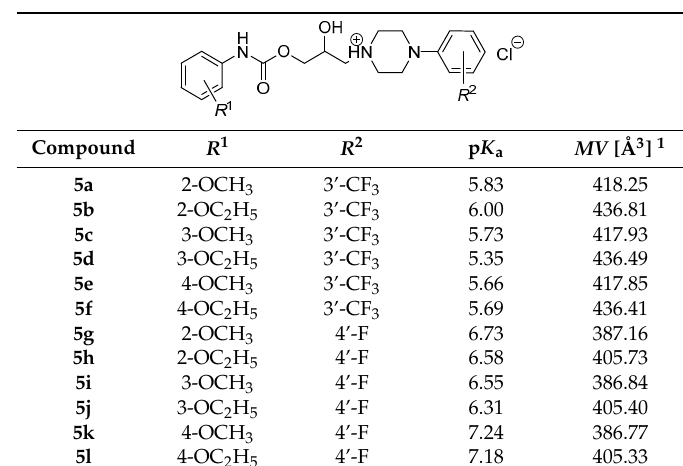
Table 1. Experimentally observed values of the dissociation constants (p K a ) of the compounds 5a – l and in silico generated molecular volume ( MV ) data.